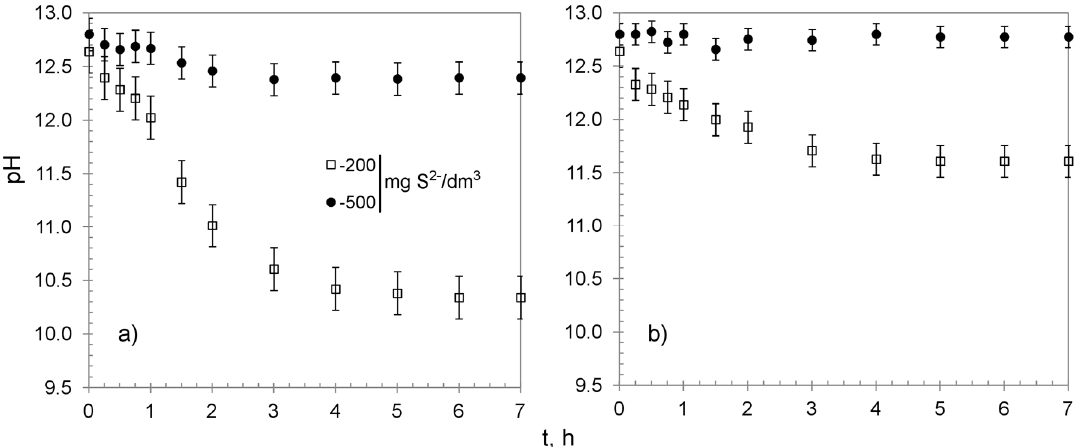
Figure 9. Changes of pH in treated solutions versus time: ( a ) CWM1#MnO 2 / H + , ( b ) CWM3#MnO 2 / H + , on average, n = 3.